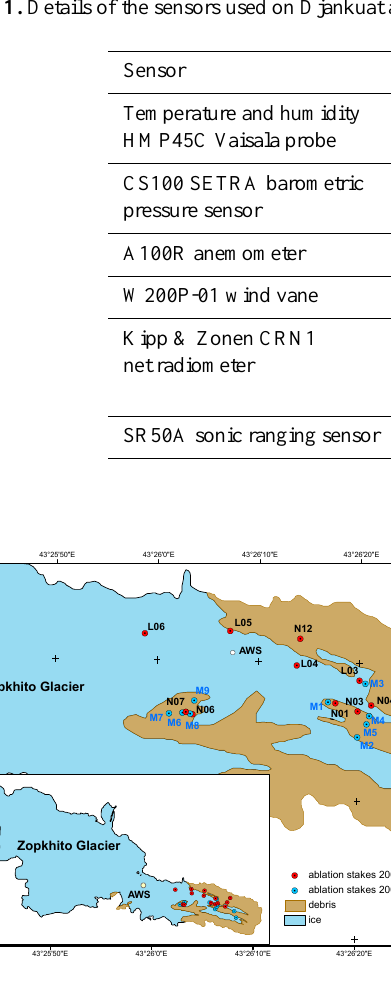
Fig. 4. Overview of Zopkhito glacier including the mapped debris cover and the position of the ablation stakes in both ablation sea- sons, as well as the location of the